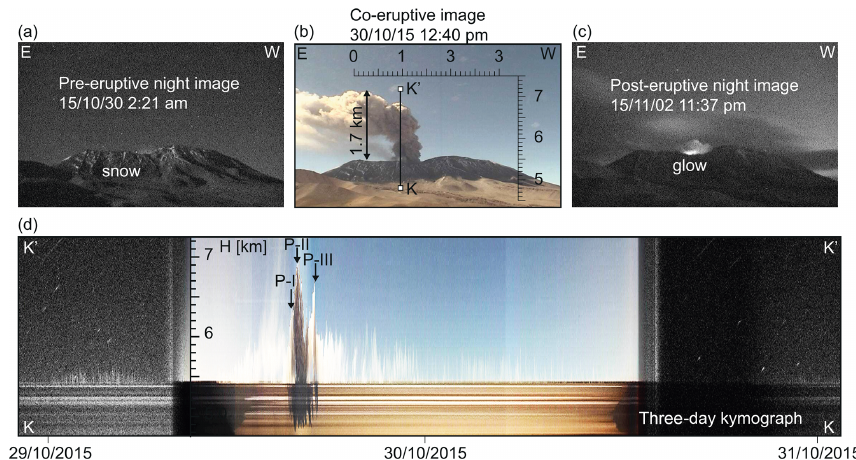
Figure 5. Camera data analysis allowing the eruption duration and height to be estimated from a camera looking from north to south (C1; see Fig. 1 for location). (a) Pre-eruptive nighttime image (29 October 2015, at 23:21UTC) of the snow-covered edifice. Local time is given in the image. (b) Co-eruptive daytime image (30 October 2015, at 15:40UTC) with a 1.7km high ash-loaded eruption column. (c) Post-eruptive image (3 November 2015, at 02:37UTC) showing increased glow. (d) Three-day kymograph extracted from 2880 images along vertical profile K − K (cid:48) (see vertical line in b ); the height scale ( H ) is shown in kilometers above sea level. P-I, P-II and P-III are the three phases exhibited by the eruptive